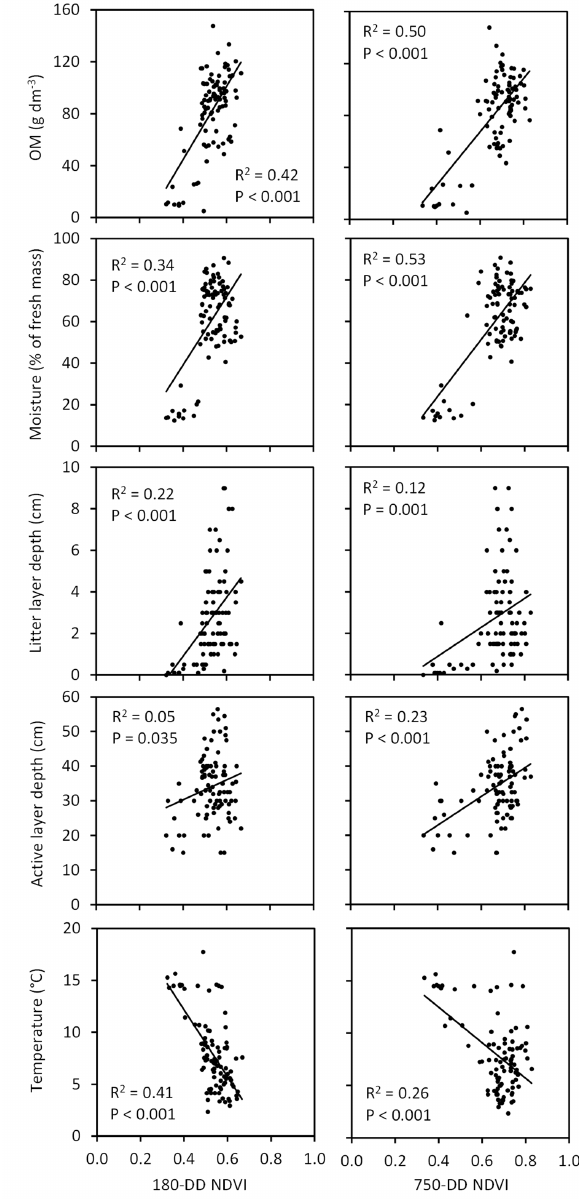
Figure 13. Associations of NDVI, extracted from QB (taken at 180 DD) and WV-2 (taken at 750 DD) images, with soil characteris- tics across the Tiksi tundra field plots. R 2 and P values, regression lines, and soil variables are as in Fig. 10, except that n = 92 in all